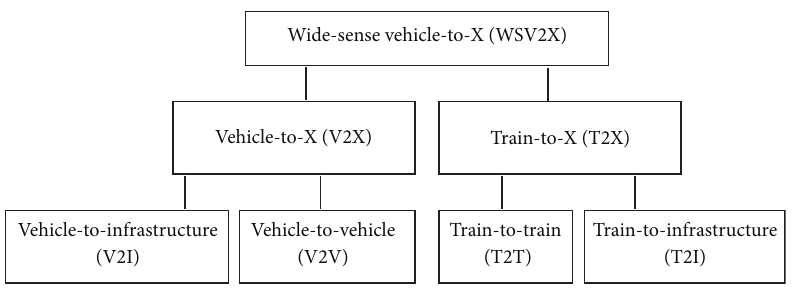
Figure 1: Block diagram of the constitution of the concept of wide-sense vehicle-to-X